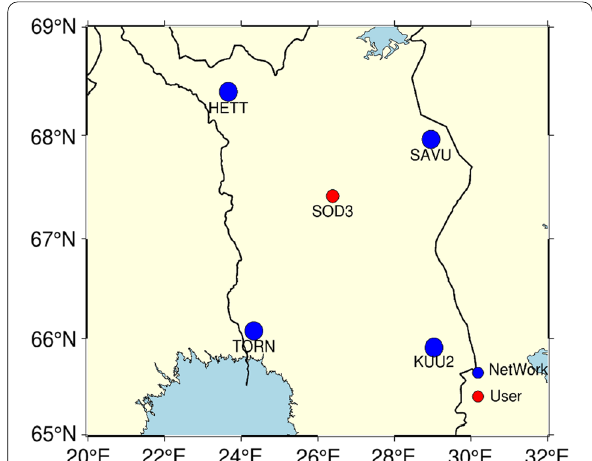
Fig. 4 Distribution of the GPS/Galileo stations from days 082 to 083 in 2021. The blue circles indicate reference stations, and the red circle denotes the user